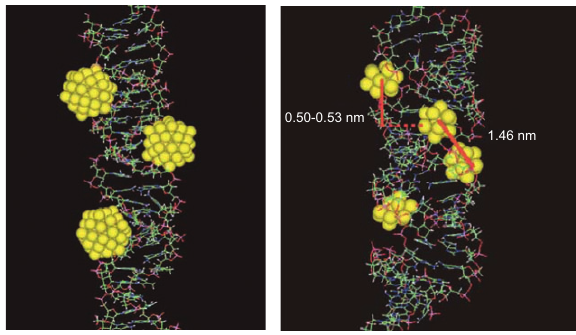
Figure 18 (Left) Modeling of the interaction of bare Au with the major grooves of B-DNA. (Right) Molecular modeling of Au clusters in A-DNA. From Ref. [135]